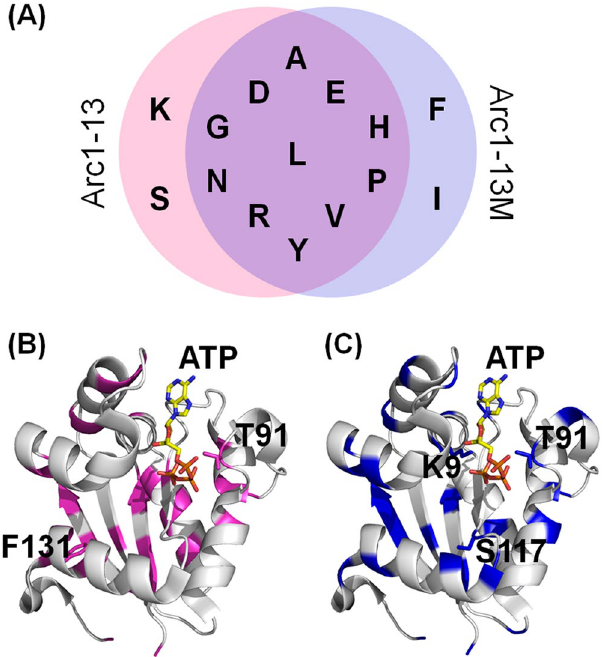
Figure 3. Two simplified proteins composed of 13 amino acid letters. ( A ) Venn diagram comparing the amino acid letters included in the two simplified proteins. ( B , C ) The monomer structures of Arc1 (PDB code, 3vvt) with ATP. The bound ATP was modeled by superimposing the Arc1 structure with the structure of Thermus thermophilus NDK with bound ATP (PDB code, 1wkl). ( B ) Amino acid residues replaced by a reduced-set of 13 amino acids in Arc1-13 are shown as a magenta backbone ribbon. The residues at positions 91 and 131, which are highly conserved among extant NDKs, are shown as sticks models. ( C ) Amino acid residues replaced with a reduced-set of 13 amino acids in Arc1-13M are rendered in blue. The residues at positions 9, 91, and 117 are shown in sticks